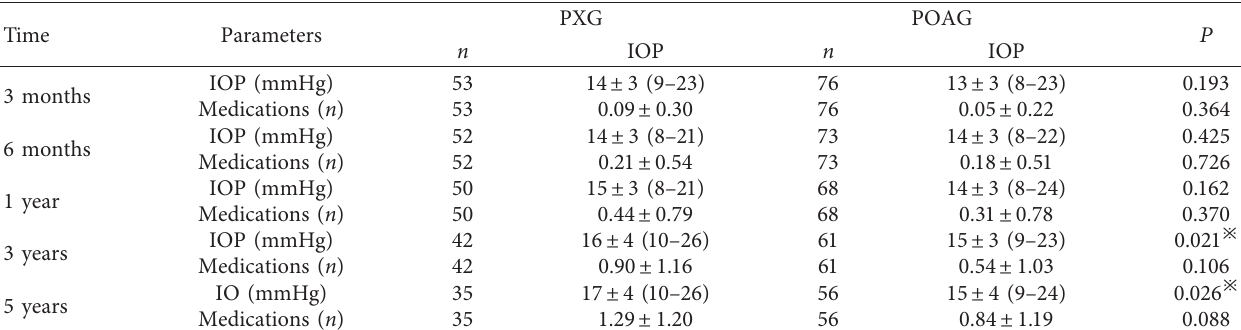
Table 2: Comparison of IOP and medications between the two groups before and after trabeculectomy. Time